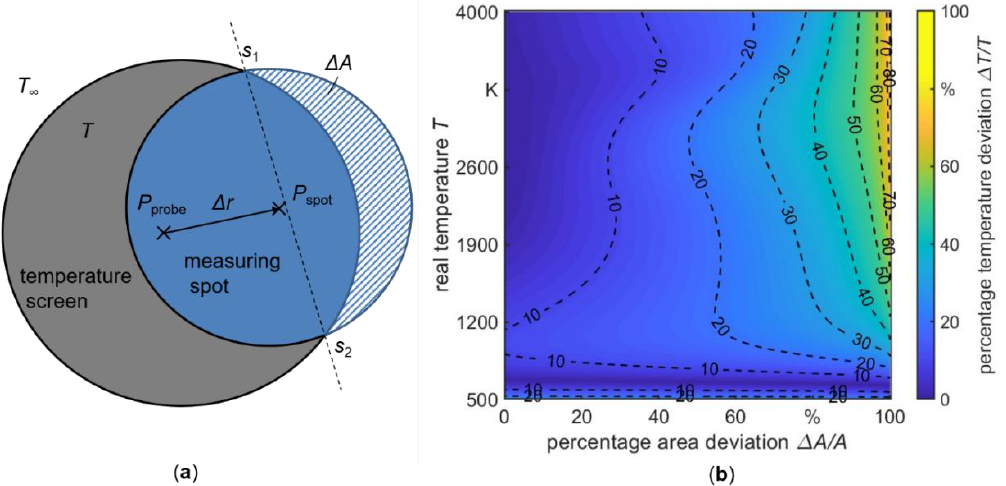
Figure 7. Influence of positioning errors on the pyrometric measurements: ( a ) geometric deviation of